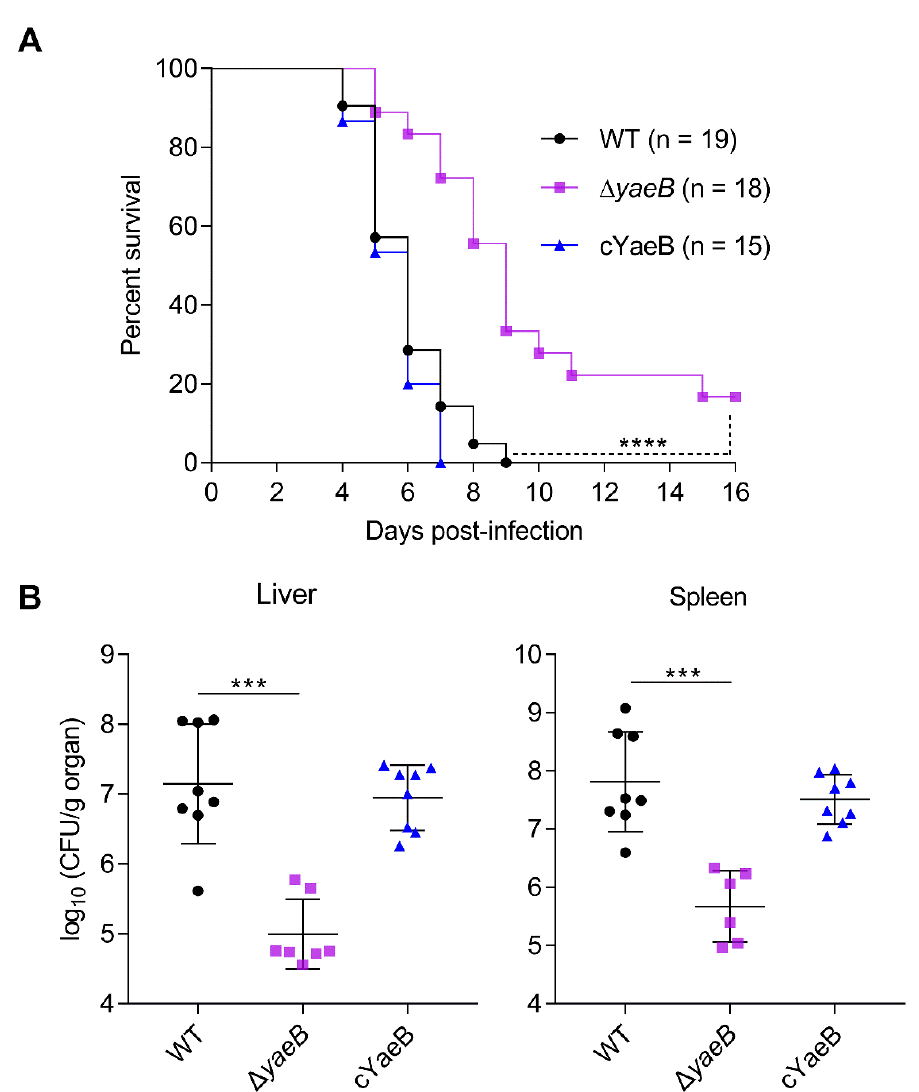
Figure 2. Deletion of yaeB attenuated S . Typhimurium virulence in mice. ( A ) To monitor survival, mice were i.p. injected with 2 × 10 4 colony-forming units (CFU) of S . Typhimurium WT strain, yaeB mutant, or cYaeb strain. Log-rank curve comparison tests were used to calculate P values. **** P < 0.0001. ( B ) Bacterial counts recovered from the livers and spleens of mice infected by i.p. injection with 5 × 10 4 CFU WT strain, yaeB mutant, or cYaeb strain at 3 dpi. Bars represent mean CFU of all mice, with significance determined by Mann–Whitney U tests. *** P < 0.001.